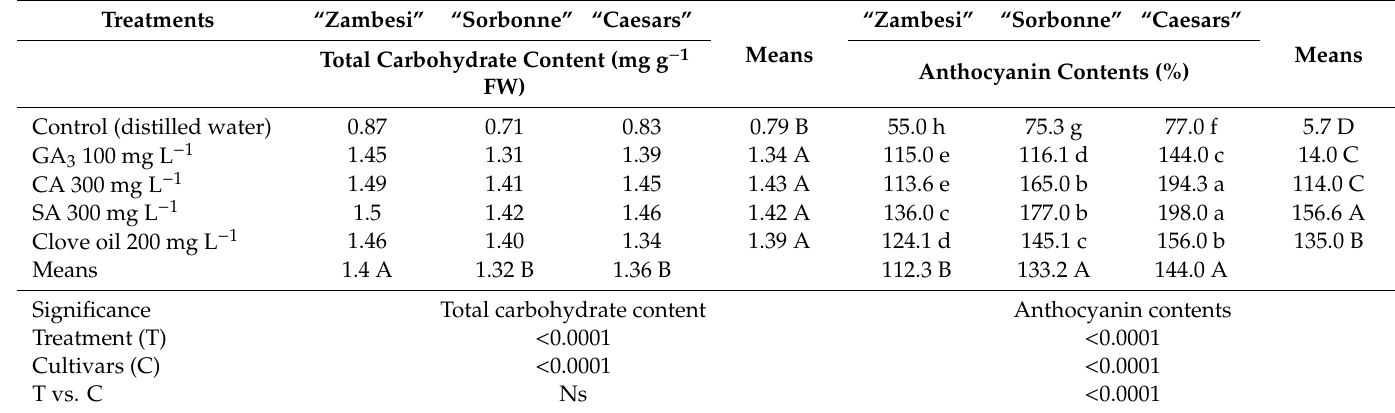
Table 6. Comparative analysis of the e ff ects of di ff erent vase solutions on the total carbohydrate contents in petals and anthocyanin contents (%) of three cultivars of cut lily